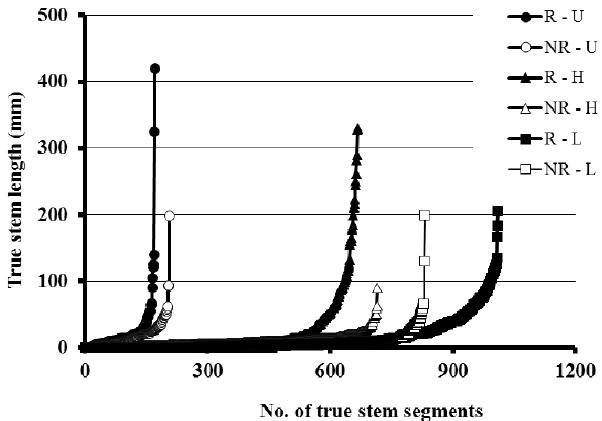
Figure 2. Cumulative distribution plot for internode true stem lengths in each of six plant population × defoliation categories. Each symbol represents a single internode with its length (mm) plotted on the Y-axis against its serial rank for length among all internodes of that plant category (X-axis) The total number and length of true stems on rhizomatous (R) and non-rhizomatous (NR) tall fescue plants subjected to hard defoliation (50 mm stubble, H), lax defoliation (100 mm stubble, L), or undefoliated (U).